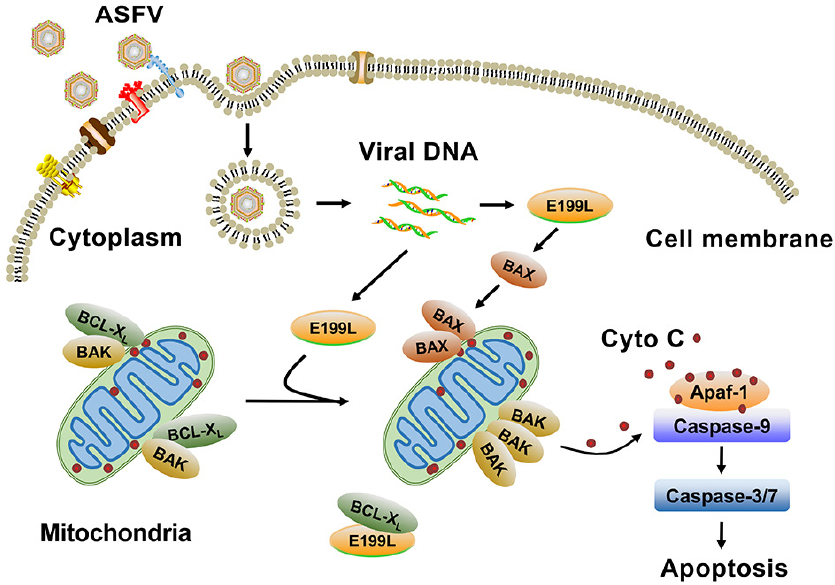
Figure 7. Model of the mitochondrial-dependent apoptosis induced by ASFV pE199L. ASFV replicates predominantly in swine monocytes and macrophages. Following binding to cell surface receptors, the virus particles are first internalized by micropinocytosis and endocytosis. Once internalized, the incoming particles undergo a process of uncoating and genome release. ASFV pE199L is expressed at a late stage of infection. The expressed pE199L can compete with BAK for BCL-X L , thus promoting BAK activation. The translocation of BAX to the mitochondria and BAX activation also can be induced by pE199L. These processes can lead to the loss of mitochondrial membrane potential, the release of cyto C, and the activation of caspase-9 and -3/7, ultimately inducing mitochondrial-dependent apoptosis.